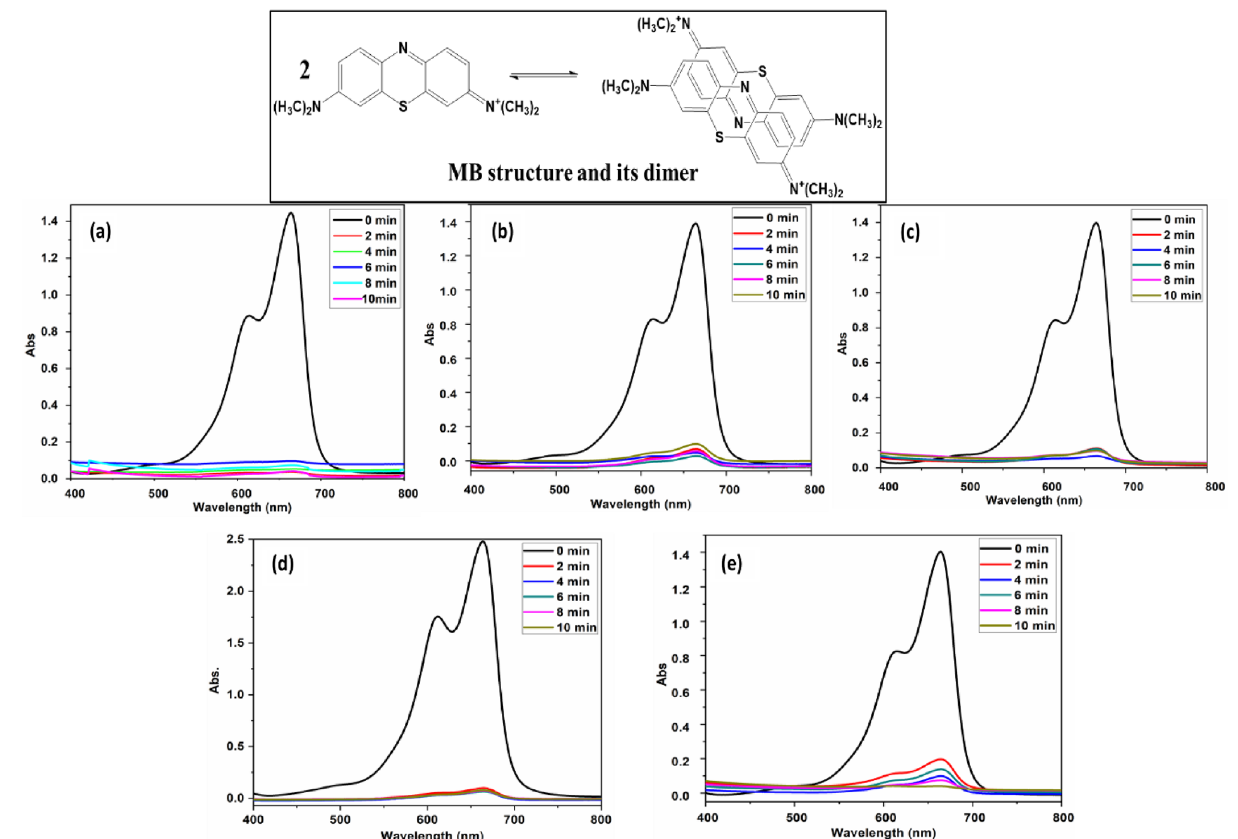
Figure 5. UV–Vis spectra of 20 ppm (MB) solution adsorption ( a , b , c , d , e ) were recorded for (10, 20, 30, 40, 50 mg) different weights of PAK at pH